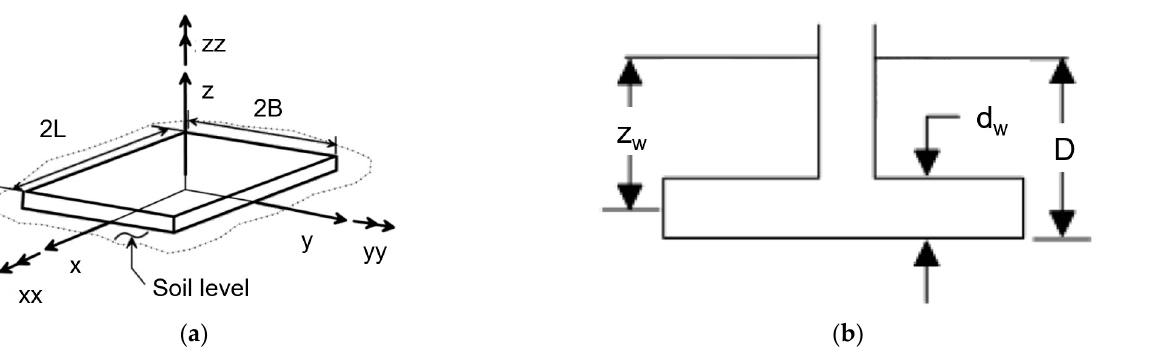
Figure 3. Foundation geometry: axonometry ( a ) and cross-section ( b ) [63] (edited by the authors).